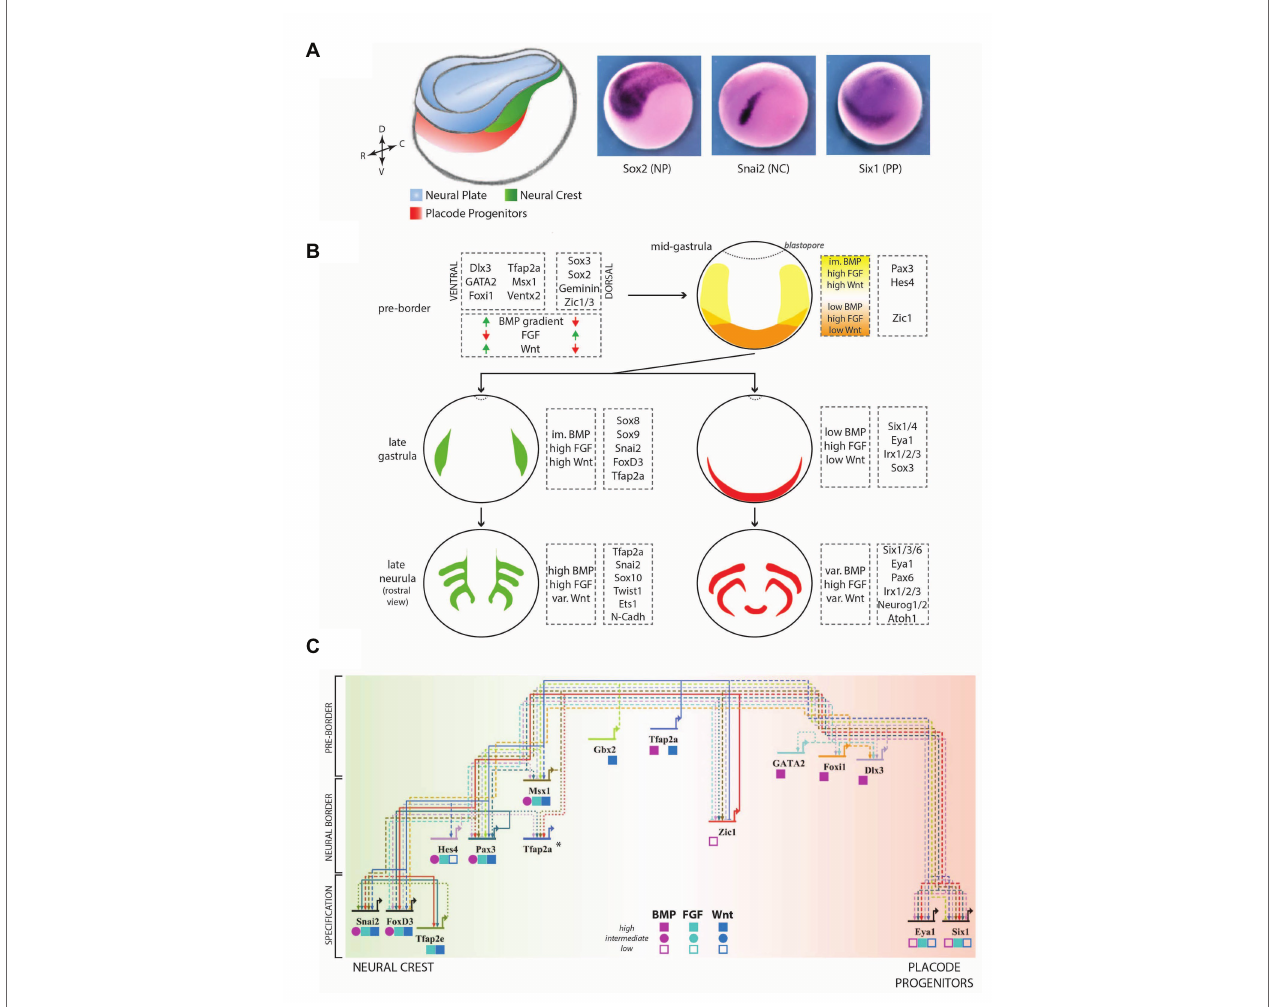
FIGURE 1 | A simplified view of the vertebrate gene regulatory network (GRN) controlling neural crest (NC) and placode induction. (A) Model of a Xenopus embryo at the mid-neurula stage, depicting the relative positions of the neural plate (NP, blue), the NC (green), and the placode progenitors (PP, red). These tissues express specific transcription factors (TFs), such as Sox2, Snai2, and Six1 respectively. DV, dorsoventral axis; RC, rostrocaudal axis. (B) The combined effects of signaling pathways and TFs lead to the development of different tissues in a temporally and spatially regulated manner. Here, the major genes involved at each stage have been indicated, along with the signaling levels of major secreted pathways (BMP, FGF, and WNT). Signaling pathways and genes have been selected according to their conserved functions in various vertebrate animal models and to the availability of detailed studies about their regulation and function in ectoderm patterning. At the mid-gastrula stage (pre-border stage), orange labels the anterior neural border (NB), and yellow depicts the posterior NB. At later stages, green and red depict the NC and the pre-placodal ectoderm respectively. im., intermediate; var., variable. (C) A synthetic view of the NB-development GRN in Xenopus laevis . Genes have been arranged from top to bottom according to the first stage during which their function is required. Genes positioned towards the left of the map favor the NC fate (green) while genes positioned towards the right of the map favor the PP fate (red). Gene-specific requirements of different signaling pathway activity have been depicted by shapes under the respective gene names (low, intermediate, and high). *Tfap2a has reiterated functions during the different stages, for which it interacts with different binding partners (de Croze et al., 2011; Rothstein and Simoes-Costa, 2020). Solid lines depict direct interactions, dashed lines depict epistasis interactions (either indirect or not proven to be direct) and dotted lines depict a feedback regulation. Arrows depict activation and bars depict repression. The GRN map has been constructed using the BioTapestry software (Longabaugh et al., 2005). Data from other model systems have not been included for the sake of simplicity, but the selected genes broadly display conserved functions in frog and chick. (For more detailed views of placode and NC GRNs, refer to Simoes-Costa and Bronner, 2015; Maharana and Schlosser, 2018; Prasad et al., 2019; Rogers and Nie, 2019; Thiery et al.,